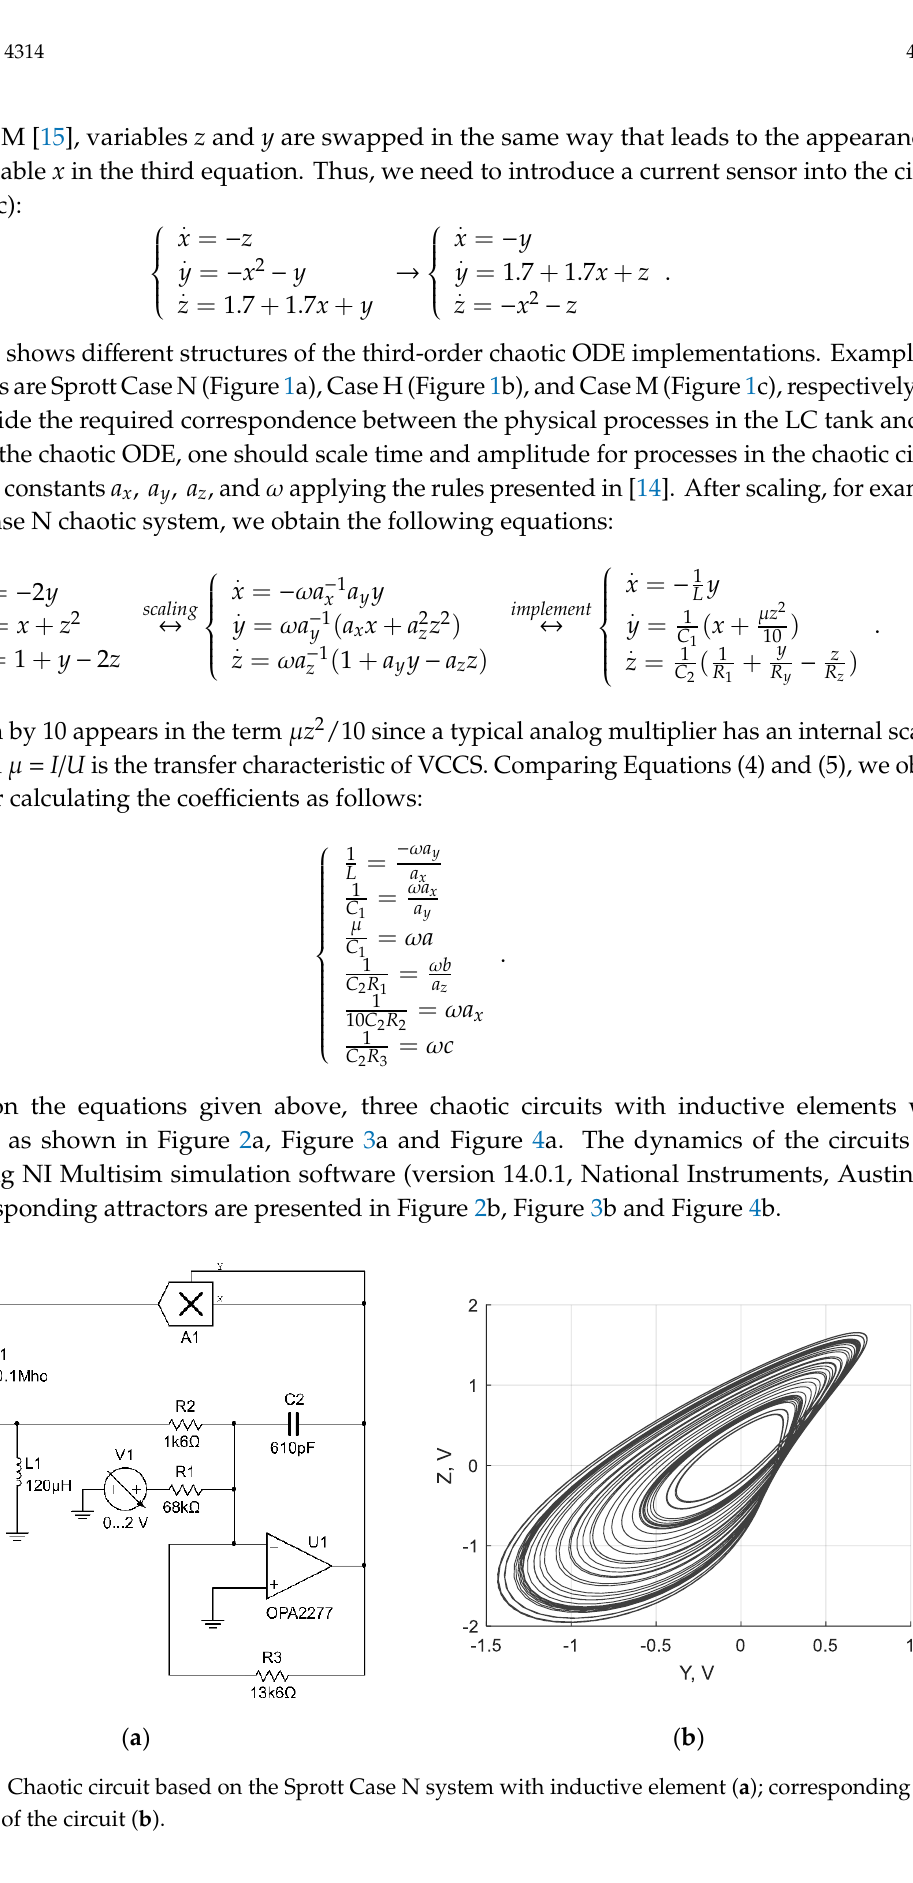
( b ) Figure 3. Chaotic circuit based on the Sprott Case H system with inductive element ( a ); corresponding attractor of the circuit ( b ). (a) (b) Figure 4. Chaotic circuit based on the Sprott Case M system with inductive element ( a ); corresponding attractor for the circuit ( b ).